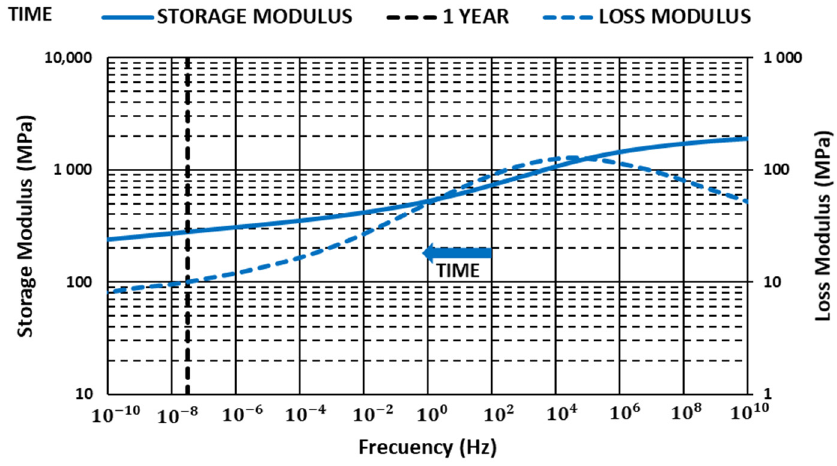
Figure 6. Variation in the storage and loss modulus with time PBT G0 (T = 50.2 ◦